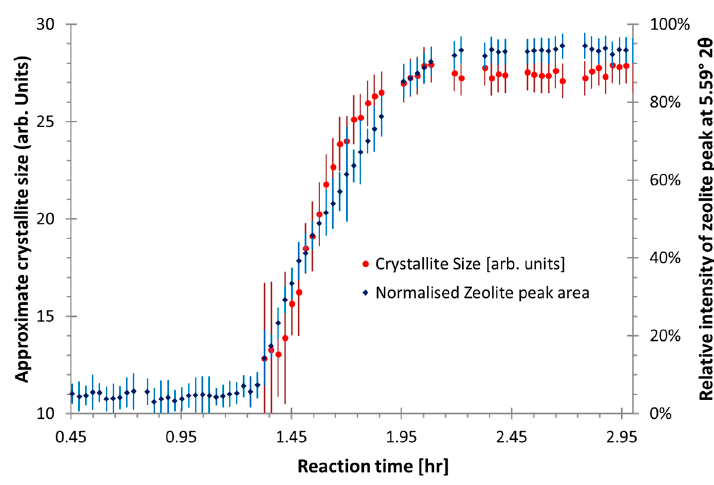
Figure 3. The relative peak area and crystallite size for a zeolite-like phase peak at Q = 1.97 Å − 1 for sample CFA-1.8-0.8-5.5. The plateau of the crystallite size as the relative peak intensity reach ~90% indicates there is nucleation period like the formation of typical zeolites, but with no crystal growth subsequently. Note, due to a fitting artifact causing crystallite size to randomly fluctuate when relative peak area is <5%, (as there is insufficient intensity to fit the peak) these peaks have been omitted for clarity. The error bars represent 1 estimated standard error from the refinement process.